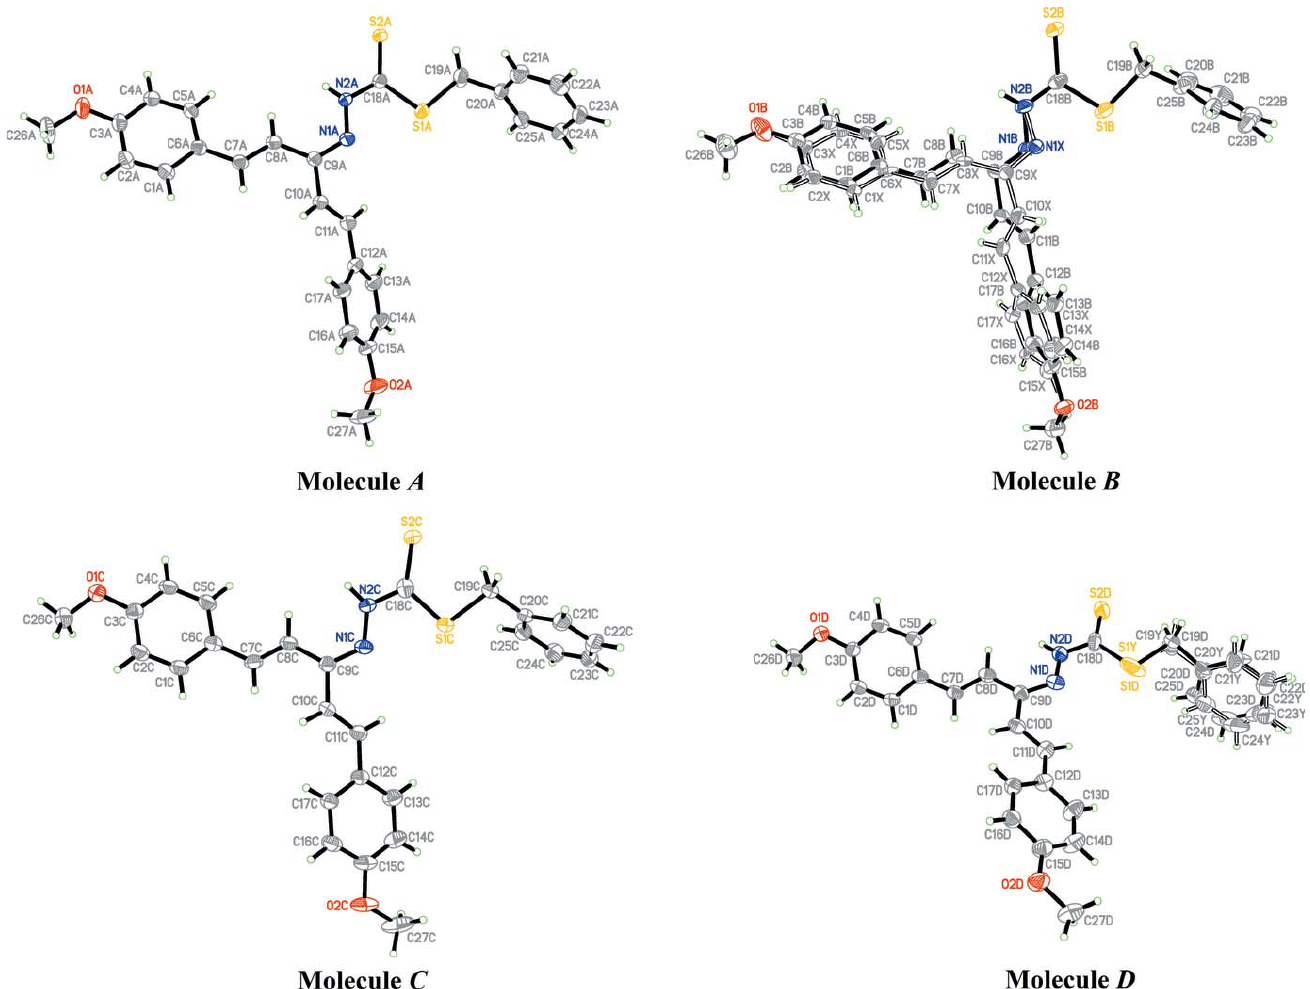
Figure 1 The structures of the four independent molecules in ( I ), showing 50% probability displacement ellipsoids and the atomic labelling